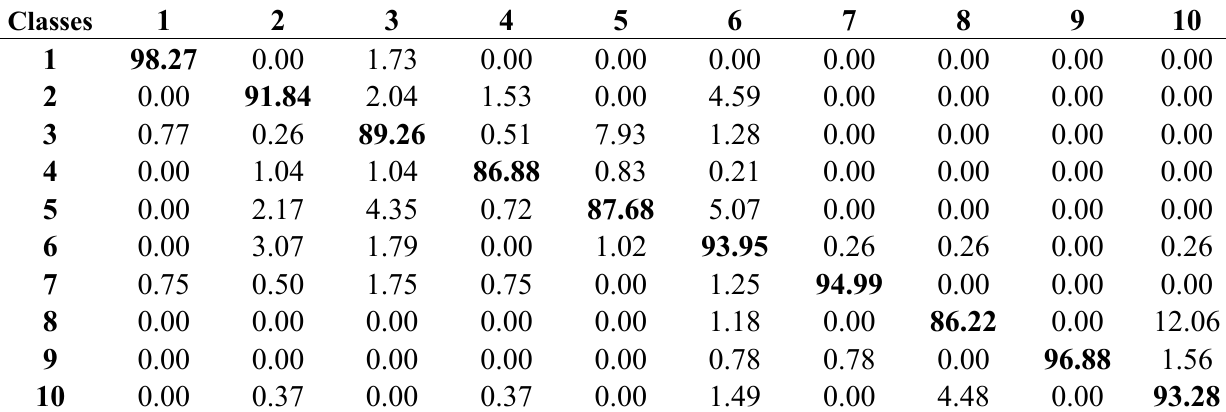
Table 1. Confusion matrix for the optimal feature vector